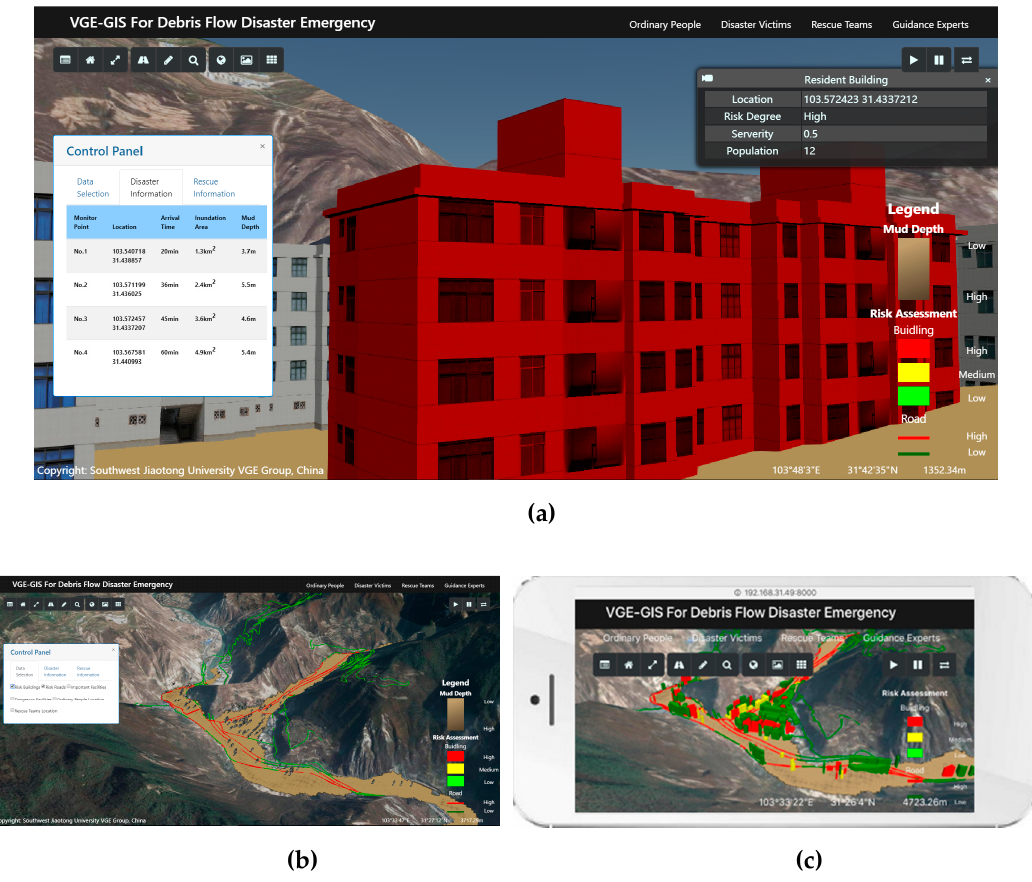
Figure 7. Virtual debris flow disaster environment for an ordinary person on desktop and mobile